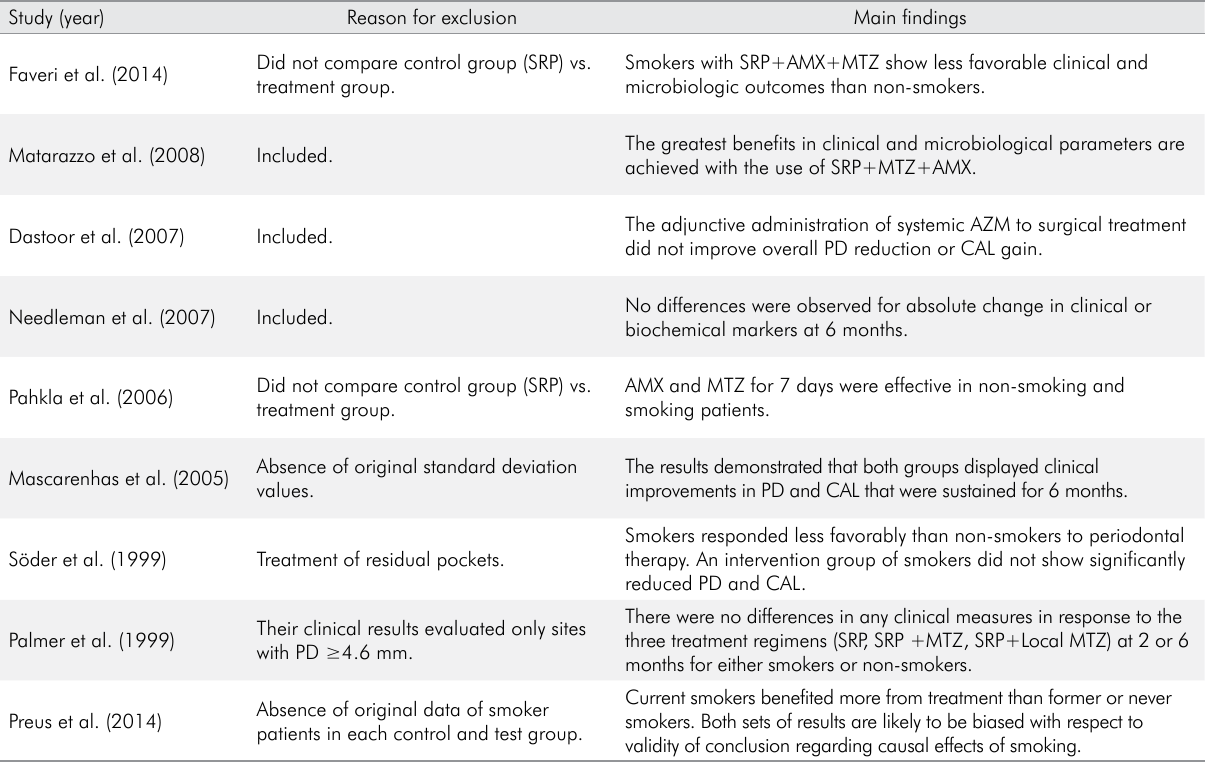
Table 1. Studies selected by reading the title and abstract, main findings related to the use of systemic antibiotics, and reasons for exclusion (n =